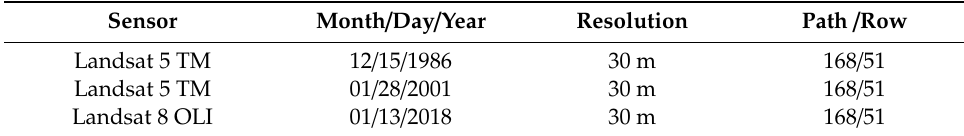
Table 2. Landsat images used for the analysis of land use and land cover (LULC) (Source: http: //